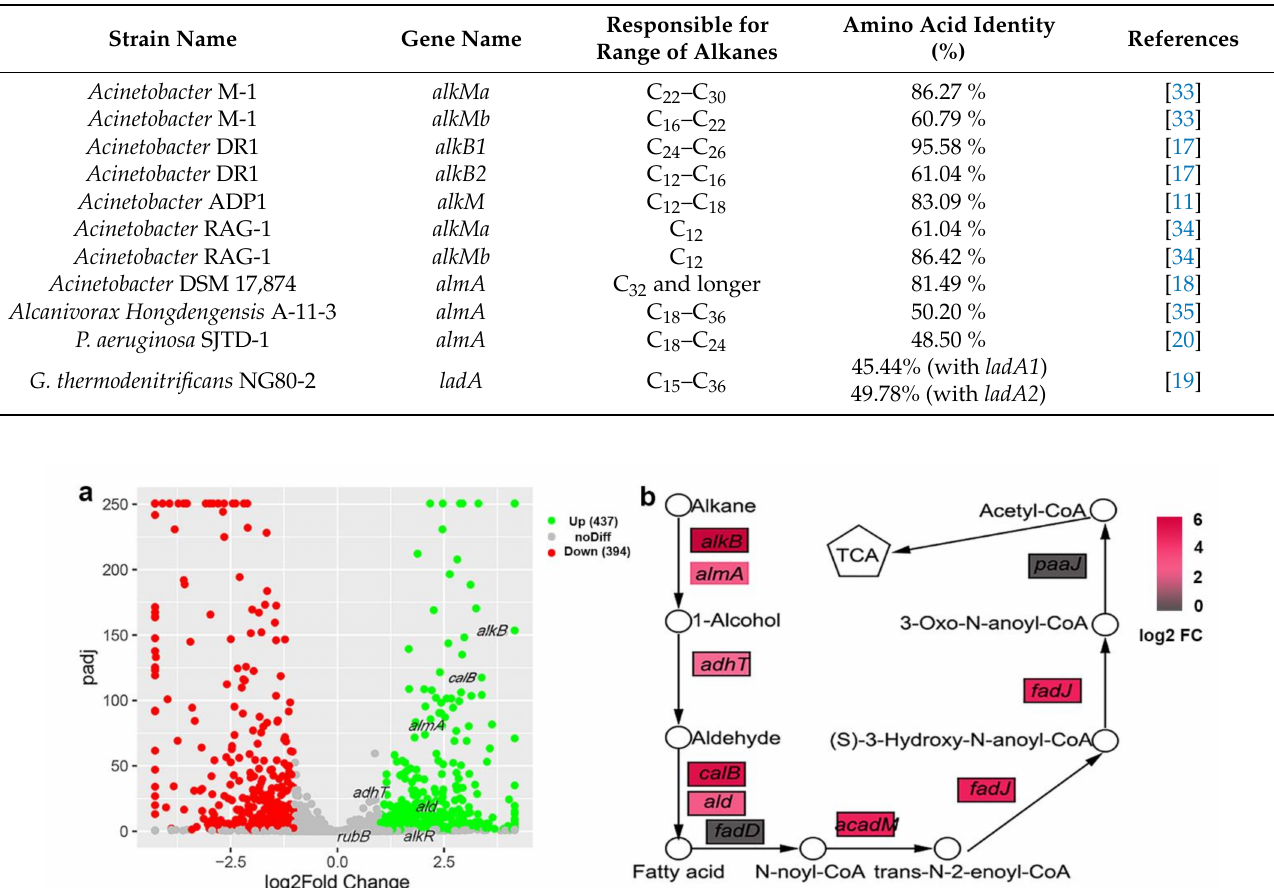
Table 1. The homologous alignment of functional alkane hydroxylases between A. pittii sw-1 and other bacteria using BLASTP.